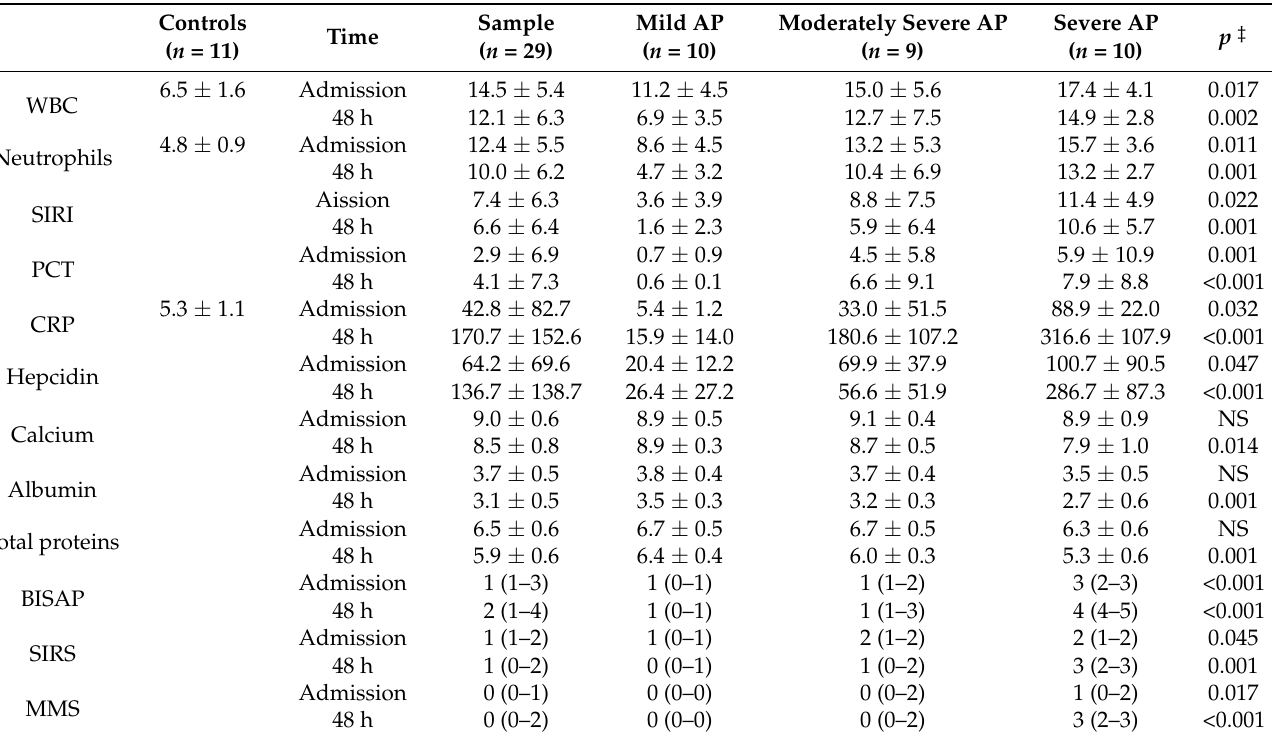
Table 2. Several biochemical markers and multifactorial scores of healthy controls and biliary AP patients included in the study. ( ‡ Kruskal–Wallis